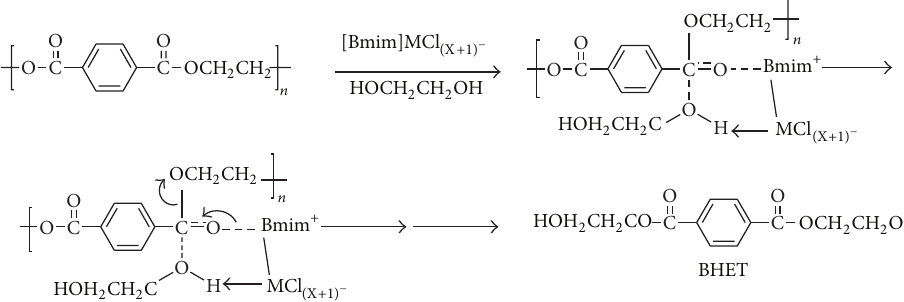
Scheme 2: Mechanism of the glycolysis of PET in the presence of metal-containing ionic liquids.